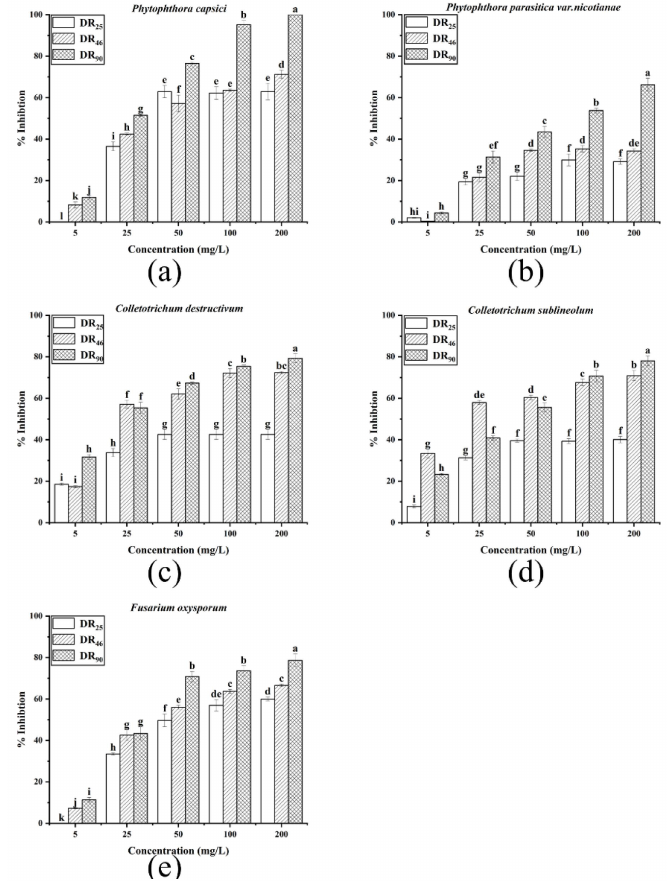
Figure 4. Mycelium growth inhibition rates of DR 25 , DR 46 and DR 90 against fungi at different concentrations (5, 25, 50, 100, 200 mg/L): ( a ) P. capsica ; ( b ) P. nicotianae ; ( c ) C. destructivum ; ( d ) C. subli- neolum ; ( e ) F. oxysporum . Error bars represent standard deviation (SD), and letters indicate significant difference at α = 0.05 according to LSD.